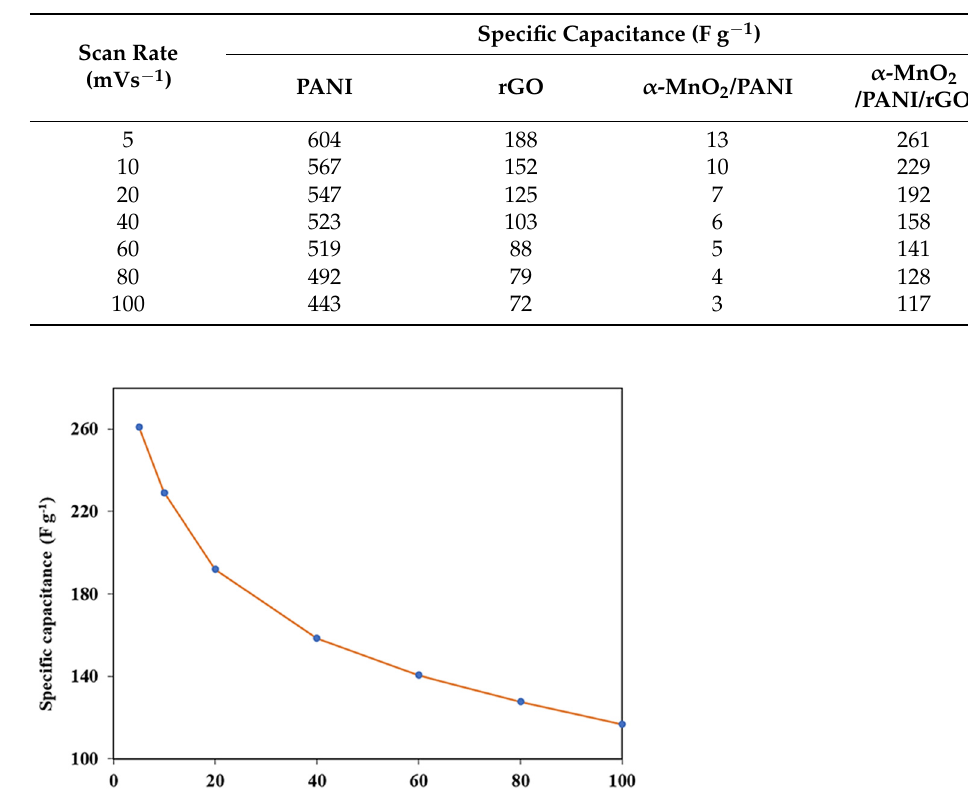
Table 1. Specific capacitance values calculated from CV.